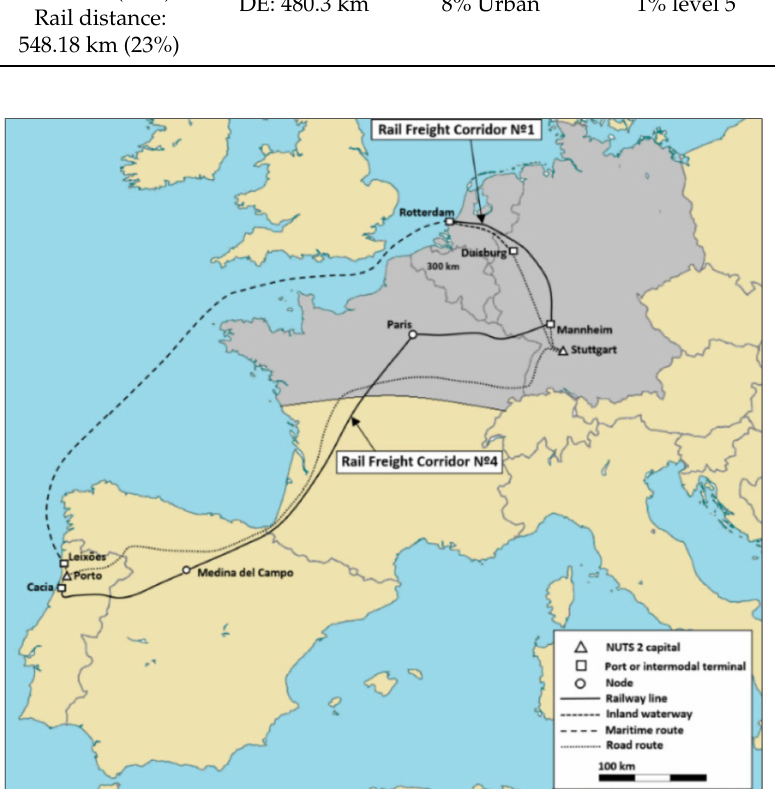
Figure 2. Road, rail, IWW and maritime routes used in transport chains between Porto and